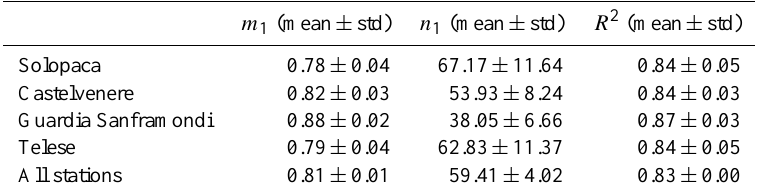
Table 5. Statistics over the period 2001–2010 of the linear regression parameters and correlation coefficient R 2 calculated at the available stations in Valle